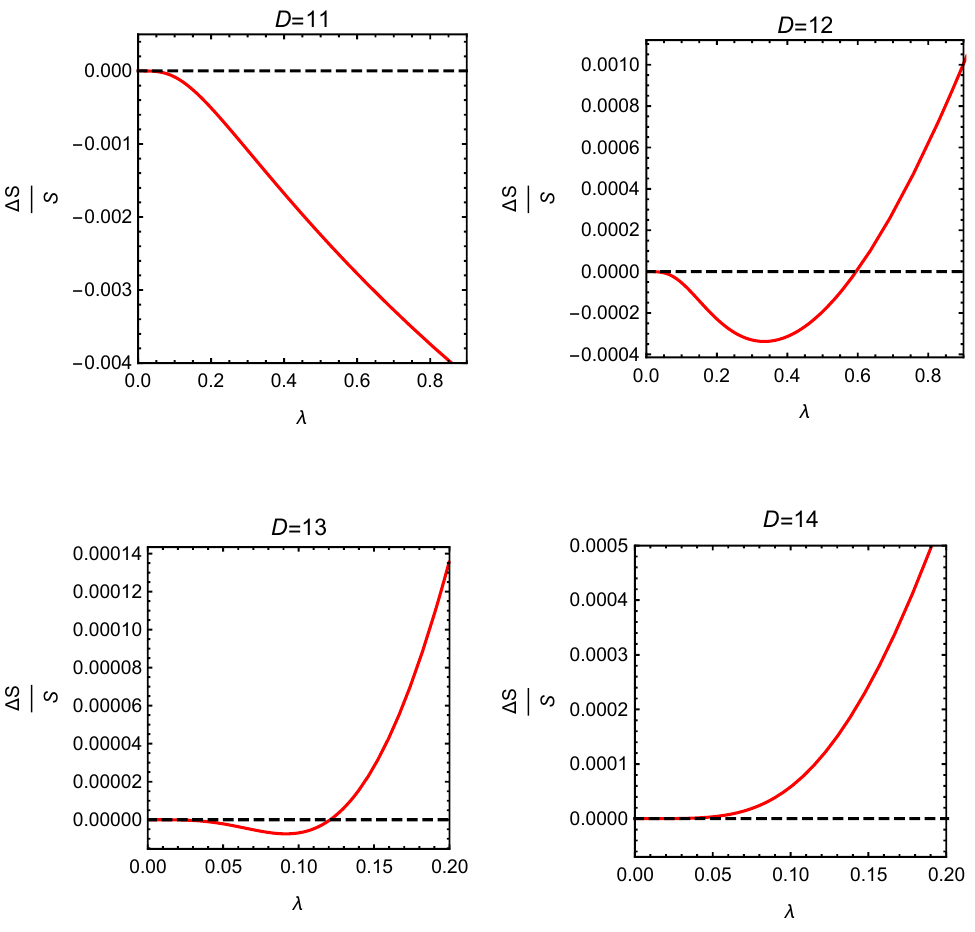
Figure 3 . Entropy di(cid:11)erence (3.16) between NUBS and UBS of the same mass as a function of non-uniformity (cid:21) (2.22). The NUBS in D = 12 ; 13 < D (cid:3) with (cid:1) S > 0 are thermodynamically stable even if they are below the critical dimension